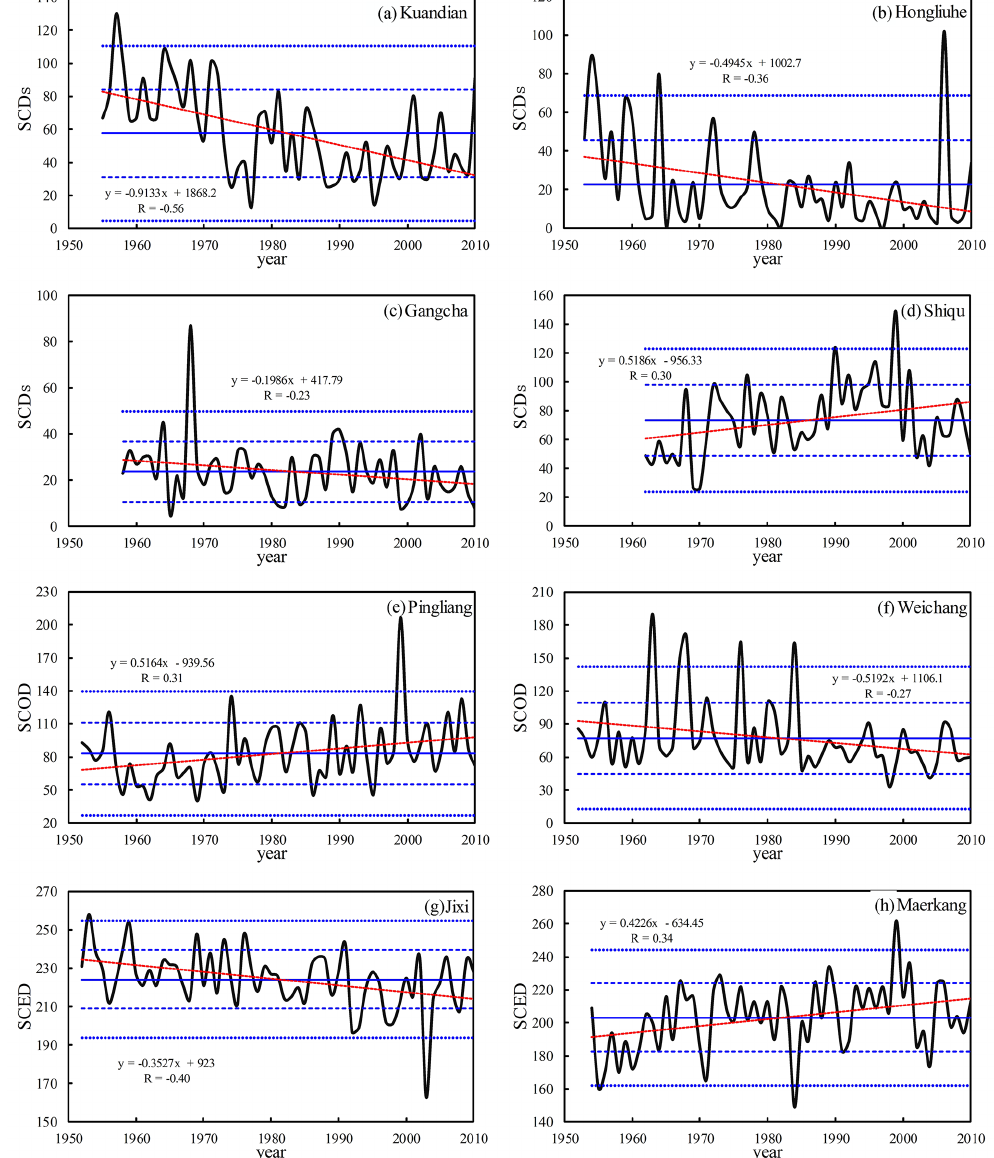
Figure 7. Variations in SCDs at Kuandian (40 ◦ 43 (cid:48) N, 124 ◦ 47 (cid:48) E; 260.1m) (a) , Hongliuhe (41 ◦ 32 (cid:48) N, 94 ◦ 40 (cid:48) E; 1573.8m) (b) , Gangcha (37 ◦ 20 (cid:48) N, 100 ◦ 08 (cid:48) E; 3301.5m) (c) , and Shiqu (32 ◦ 59 (cid:48) N, 98 ◦ 06 (cid:48) E; 4533.0m) (d) ; SCOD at Pingliang (35 ◦ 33 (cid:48) N, 106 ◦ 40 (cid:48) E; 1412.0m) (e) and Weichang (41 ◦ 56 (cid:48) N, 117 ◦ 45 (cid:48) E; 842.8m) (f) ; and SCED at Jixi (45 ◦ 18 (cid:48) N, 130 ◦ 56 (cid:48) E; 280.8m) (g) , and Maerkang (31 ◦ 54 (cid:48) N, 102 ◦ 54 (cid:48) E; 2664.4m) (h) . (The unit on the y axis in the panels (e) , (f) , (g) , and (h) denotes the Julian day using 1 September as